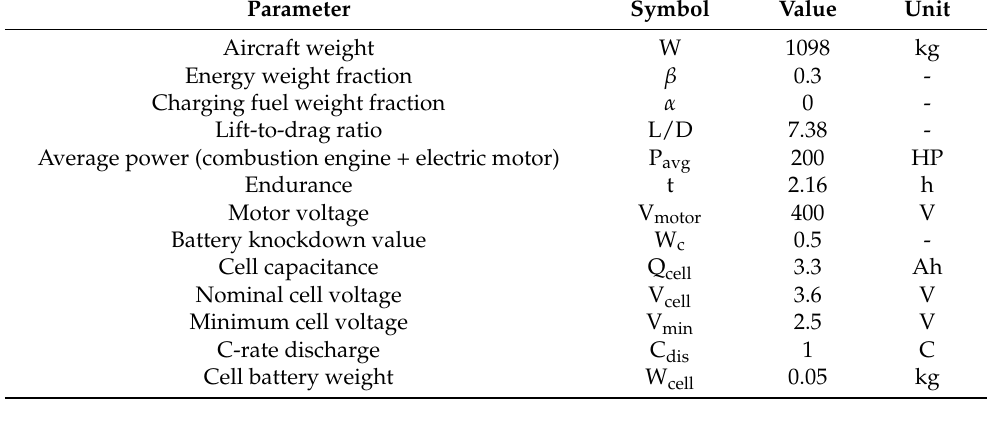
Table 2. Determined basic output parameters for the calculation of the hybrid propulsion system. Source: [23] processed by authors.